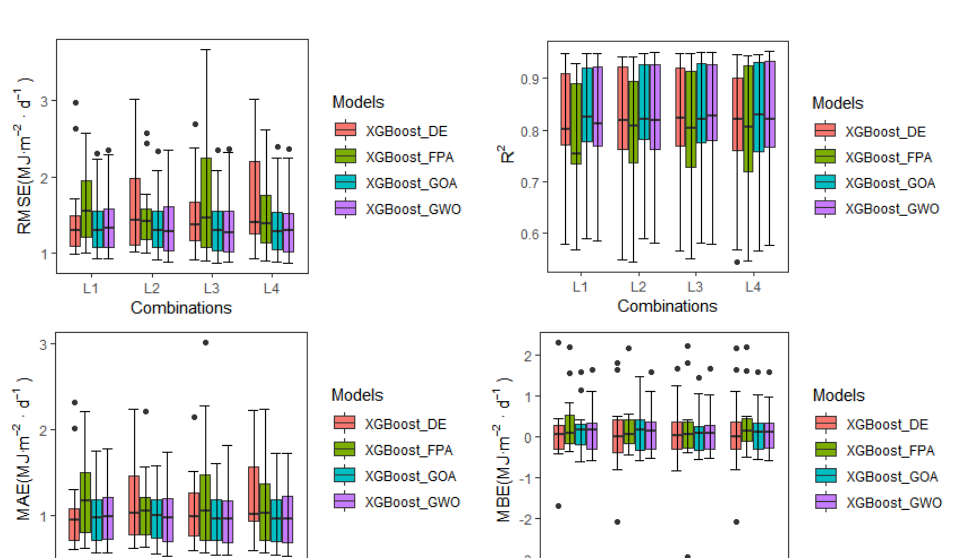
Figure 4. Sca tt er plots of R d predicted by the coupling models based on ground weather station data in Beijing.